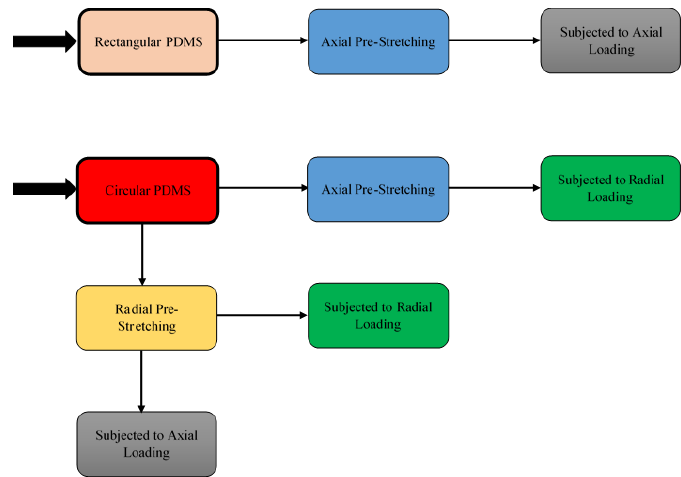
Figure 5. The procedure followed to examine the effect of axial and radial pre-stretching on the stretchability of the printed circuits under axial and radial loads.